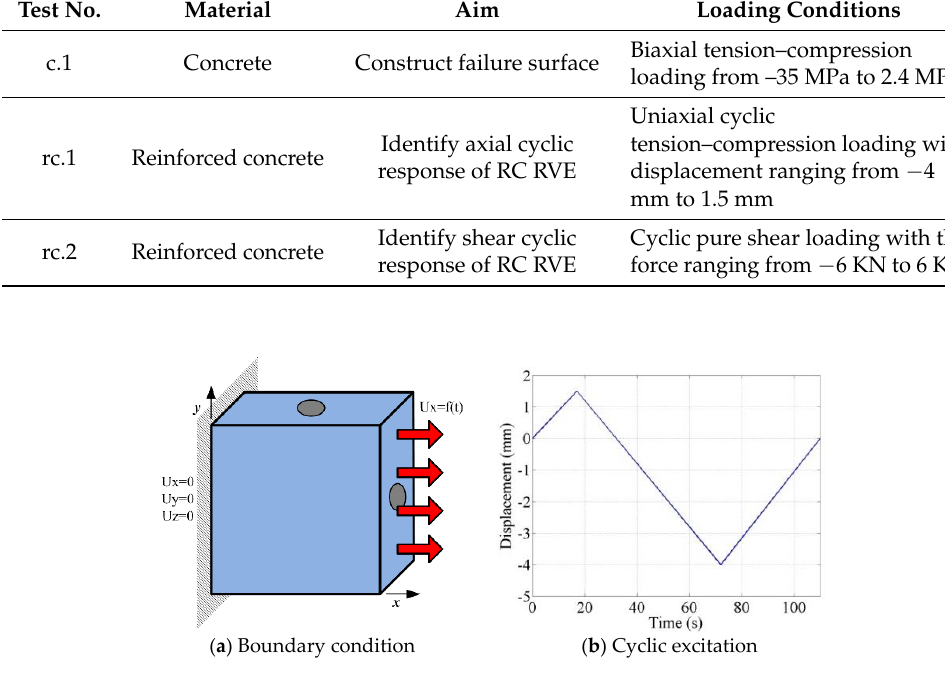
Figure 9. Representative volume elements for local finite element test; ( a ) Concrete representative volume element (RVE); ( b ) RC RVE. Table 3. Configuration of the local test. RVE: representative volume element.